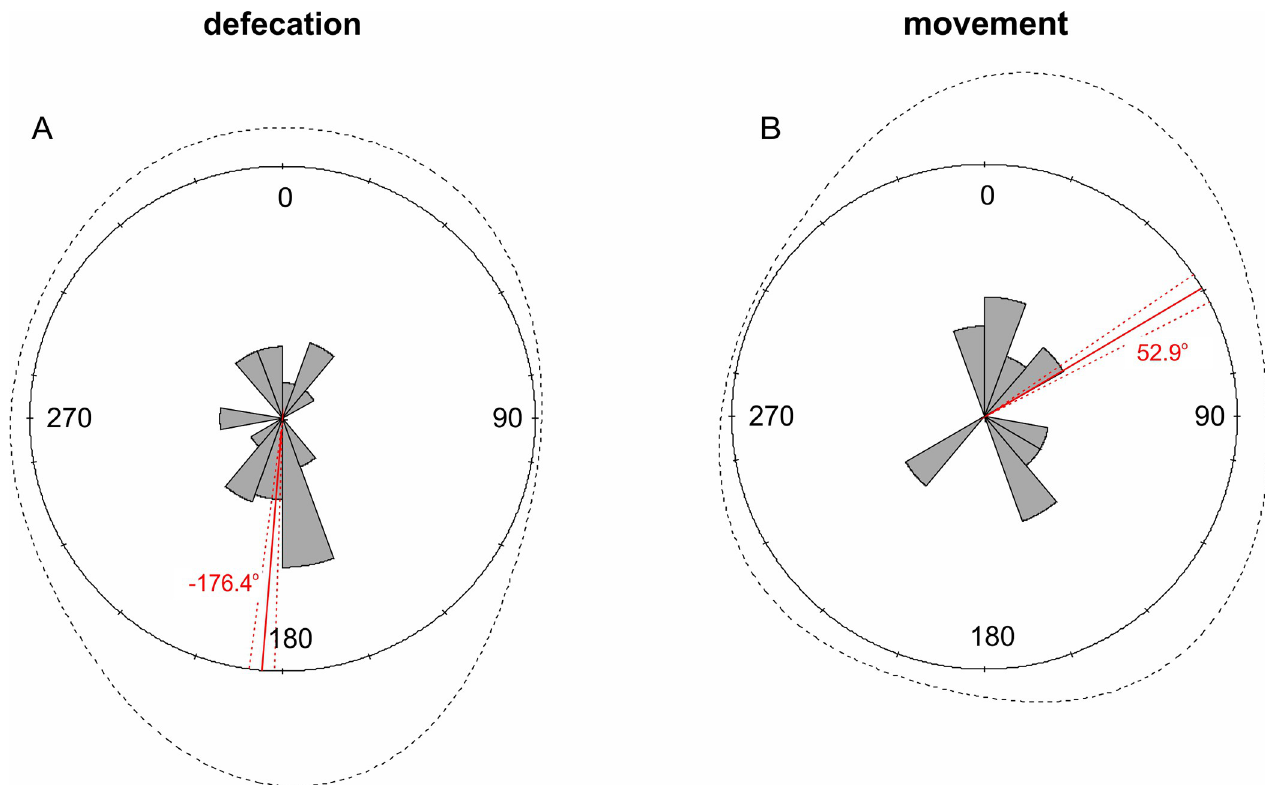
Fig 4. Differences between Leopard ( Panthera pardus fusca ) orientation (A) during defecation and (B) movement. The solid red line denotes the circular mean, while the dashed red line represents the standard deviation.